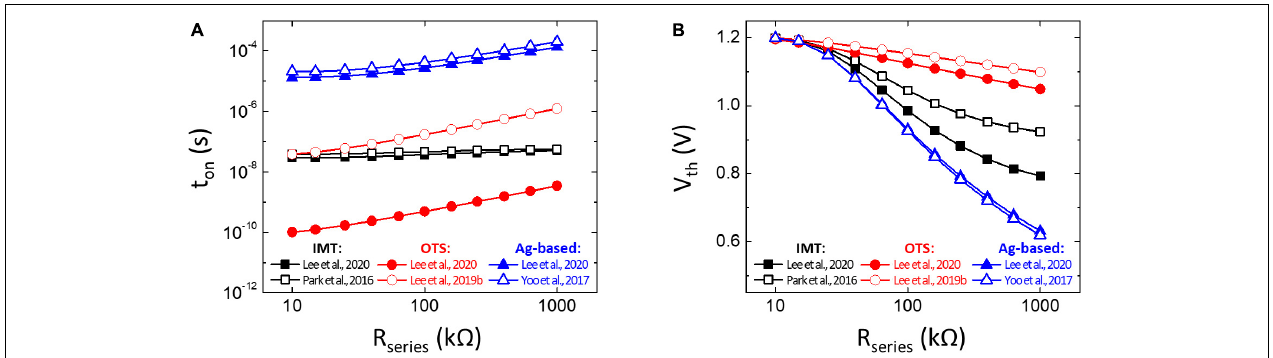
FIGURE 8 | V – t Model prediction on (A) t on and (B) V th of the neuron circuit based on insulator–metal transition (IMT) (Park et al., 2016; Lee et al., 2020), ovonic threshold switching (OTS) (Lee et al., 2019b, 2020), and Ag-based (Yoo et al., 2017; Lee et al., 2020) selectors. R series is assumed to range from 10 k (cid:127) to 1 M (cid:127) . The value of an integrated capacitor in each condition is listed in Table 1